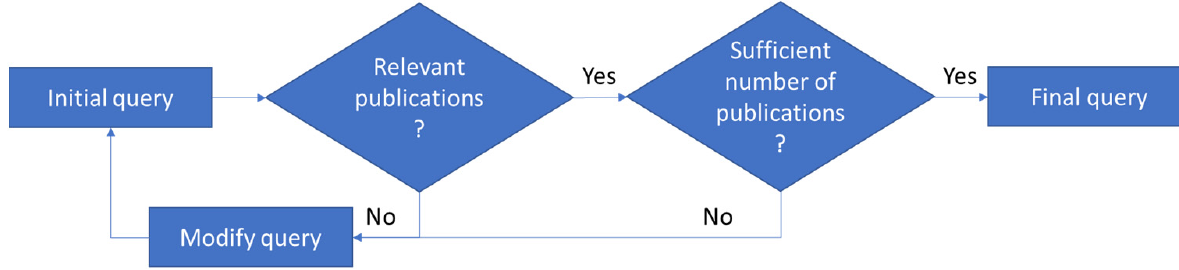
Figure 2. Query design process.